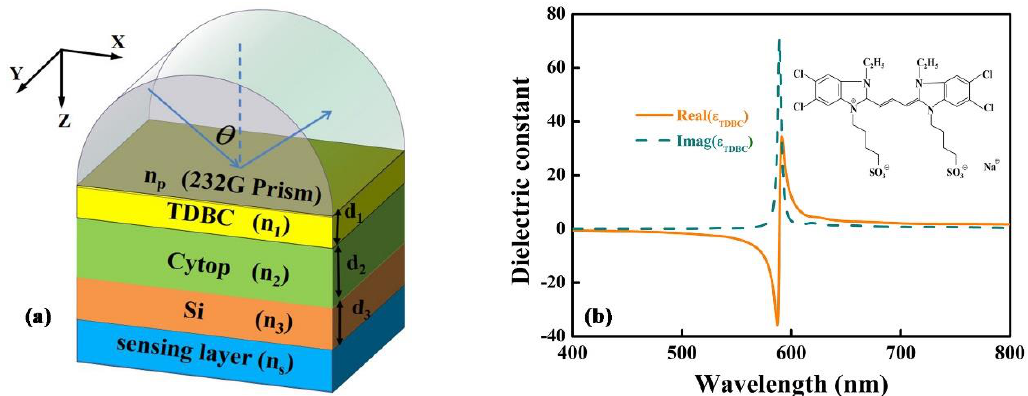
Figure 1. ( a ) The schematic view of the designing biosensor. ( b ) The complex dielectric function of the TDBC film.